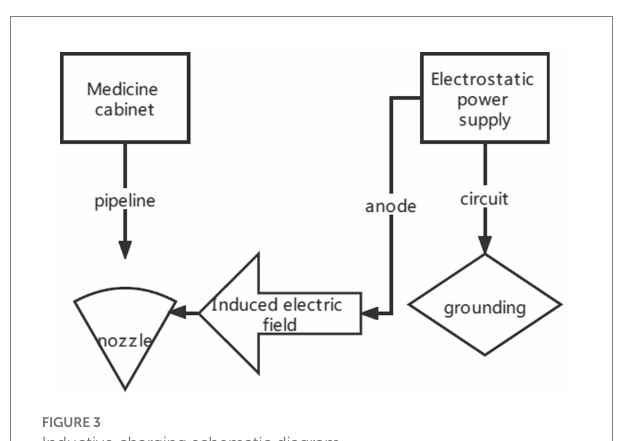
FIGURE 3 Inductive charging schematic diagram.